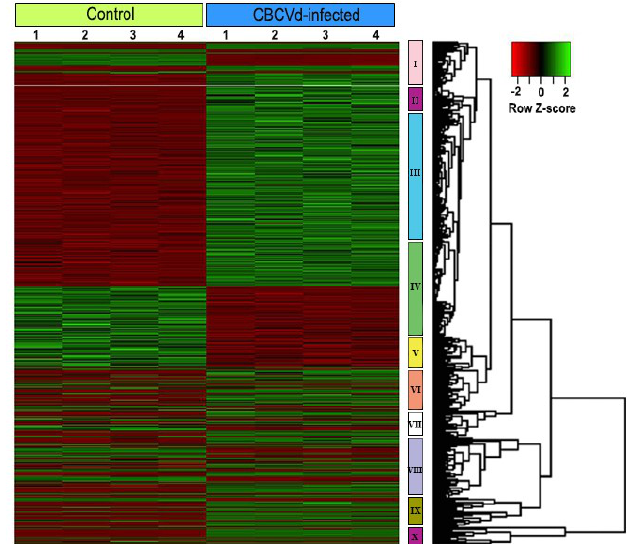
Figure 3. Heat map and complete linkage hierarchical clustering of log 2 fold change of differentially expressed genes between CBCVd-infected compared with mock inoculated leaves of hop. Colors on vertical represent the clustered genes based on gene expression, the horizontal line represents the single gene. The color scale ranges from saturated red for log 2 ratios − 2.0 and below, to saturated green for log 2 ratios +2.0 and above.